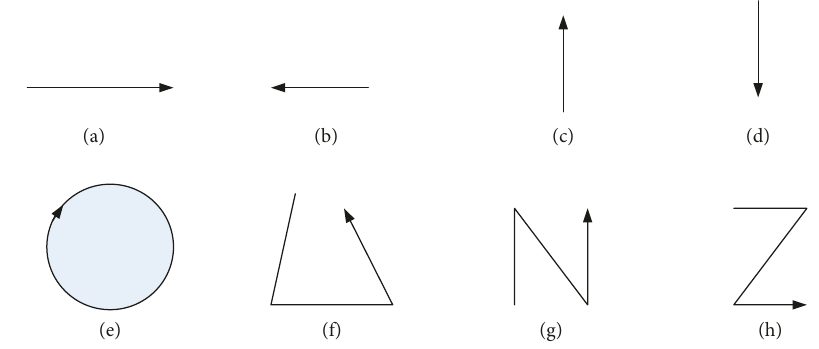
Figure 6: Defining 8 trajectories. Table 2: Dynamic gesture setting